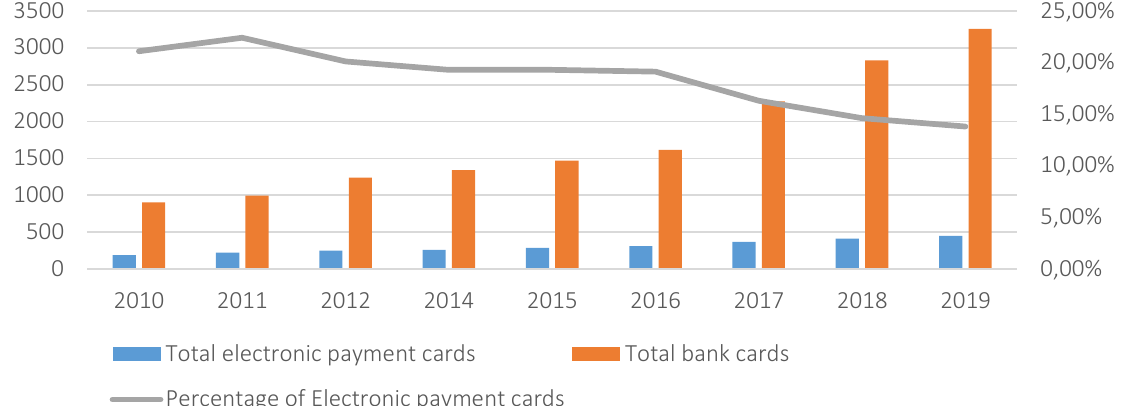
Figure 1. Growth in using bankcards at the Bank of Palestine during the period of